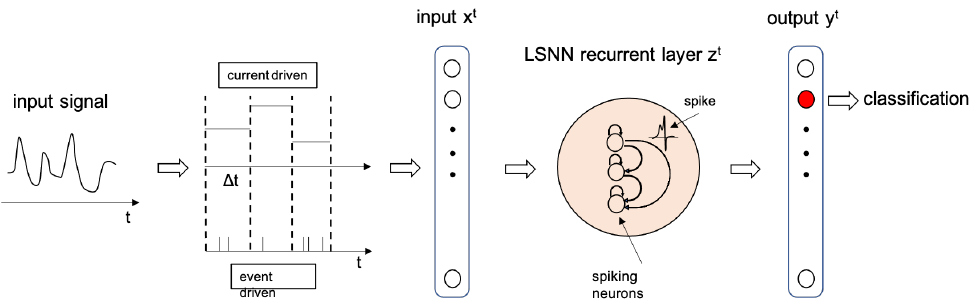
Figure 3. Full pipeline. The signal over time is encoded in current or events. Once transformed, it will be given as input to the SNN which will classify the data as a healthy or damaged